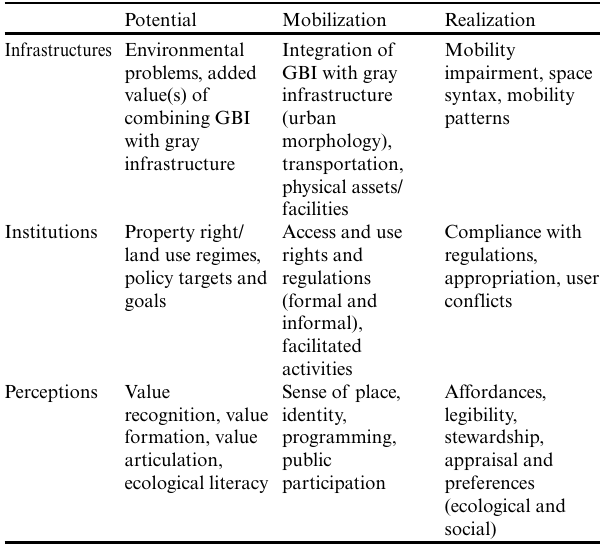
Table 1. A matrix for positioning individual cases based on which of the three filters (vertical) and which steps of the benefit flow (horizontal) they focused on. The content of the cells indicates questions and issues that can be addressed and connected through the three filters framework.